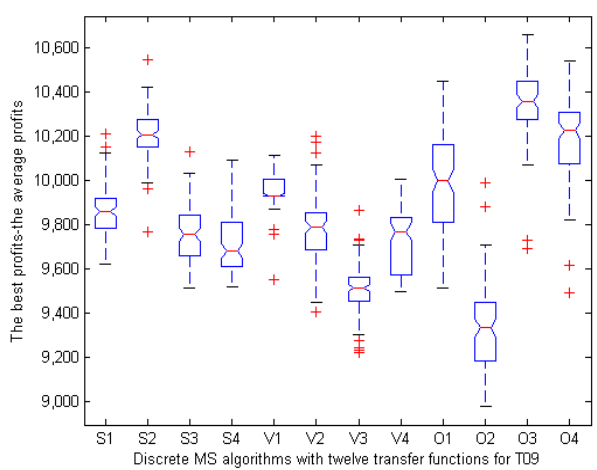
Figure 6. Boxplot of the best values on T09 in 100 runs.